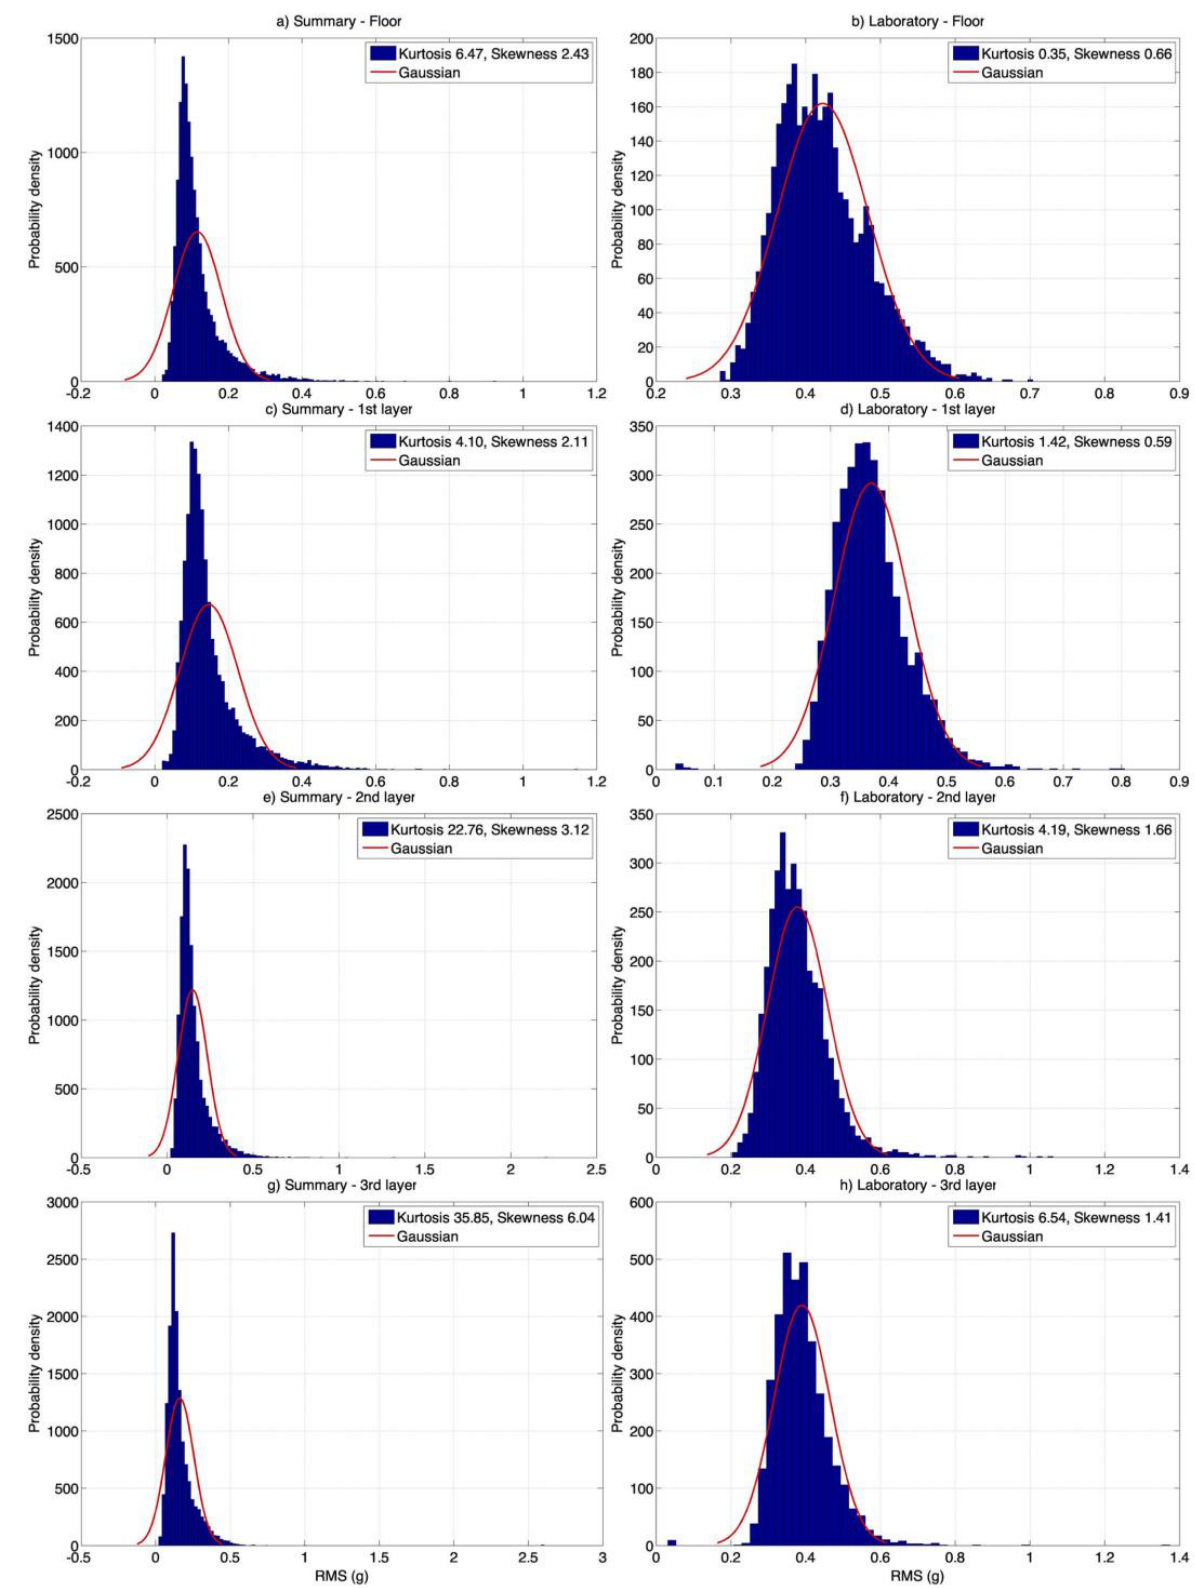
Figure 10. PDF for recorded vertical RMS (g) at field measurement and in laboratory at, ( a ) Summary-Floor, ( b ) Laboratory-Floor, ( c ) Summary-1st layer, ( d ) Laboratory-1st layer, ( e ) Summary-2nd layer, ( f ) Laboratory-2nd layer, ( g ) Summary-3rd layer, ( h ) Laboratory-3rd layer.